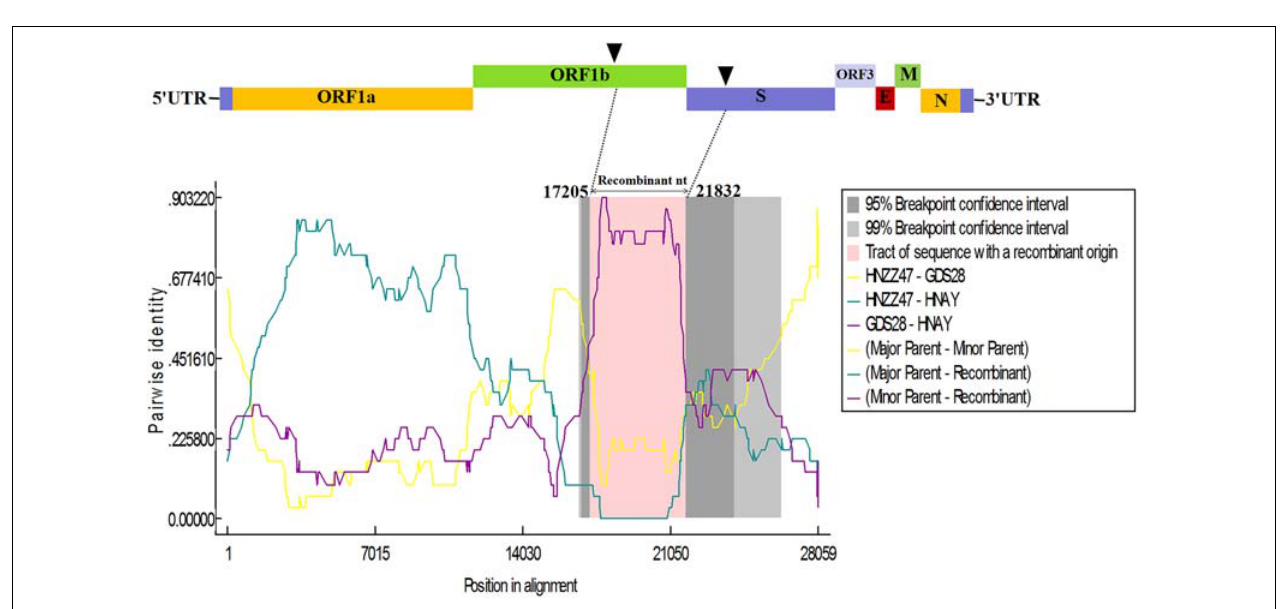
FIGURE 5 | Phylogenetic analysis of PEDV complete genome and S genes. (A) Multiple sequence alignments were generated with Clustal X and complete genome phylogenetic tree was constructed using neighbor joining (NJ) method and supported with a bootstrap test of 1,000 replicates in MEGA7. “ • ” indicates the PEDV strains isolated in this study. (B) S gene phylogenetic tree was constructed by using the same method as above. “ • ” indicates the PEDV strains isolated in this study. Scale bars indicate nucleotide substitutions per site.